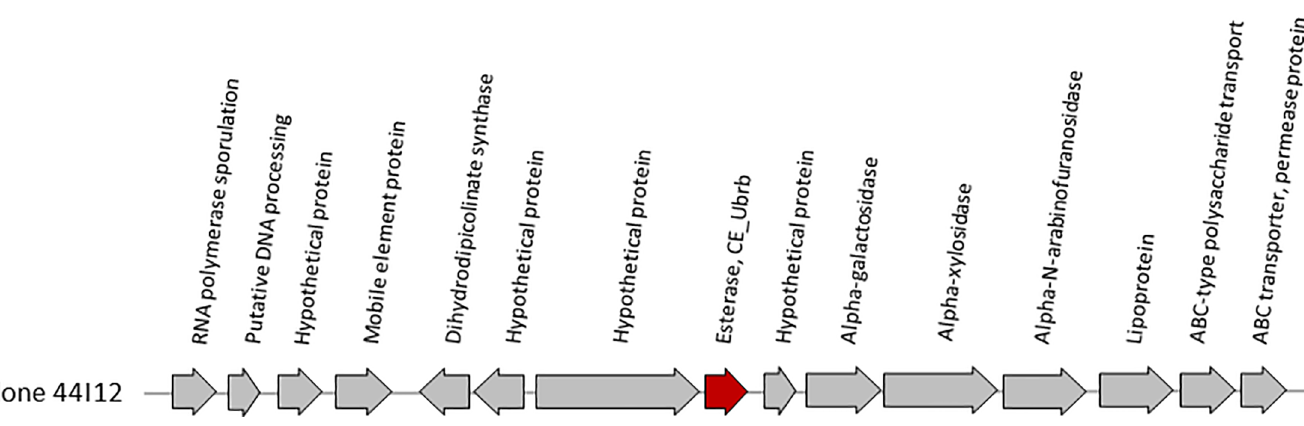
Fig 4. Graphical representation of the metagenomic sequence of clone 44I12, and RAST annotation of the identified ORFs. Red arrow: CE_Ubrb encoding